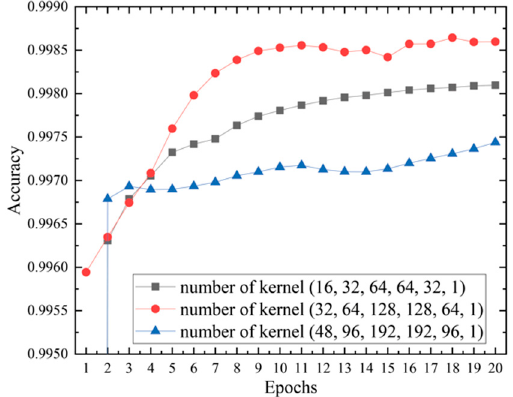
Figure 5. Results of SCDA with different number of kernels on yeast data. The kernel combination with (32, 64, 128, 128, 64, 1) achieves the best performance.